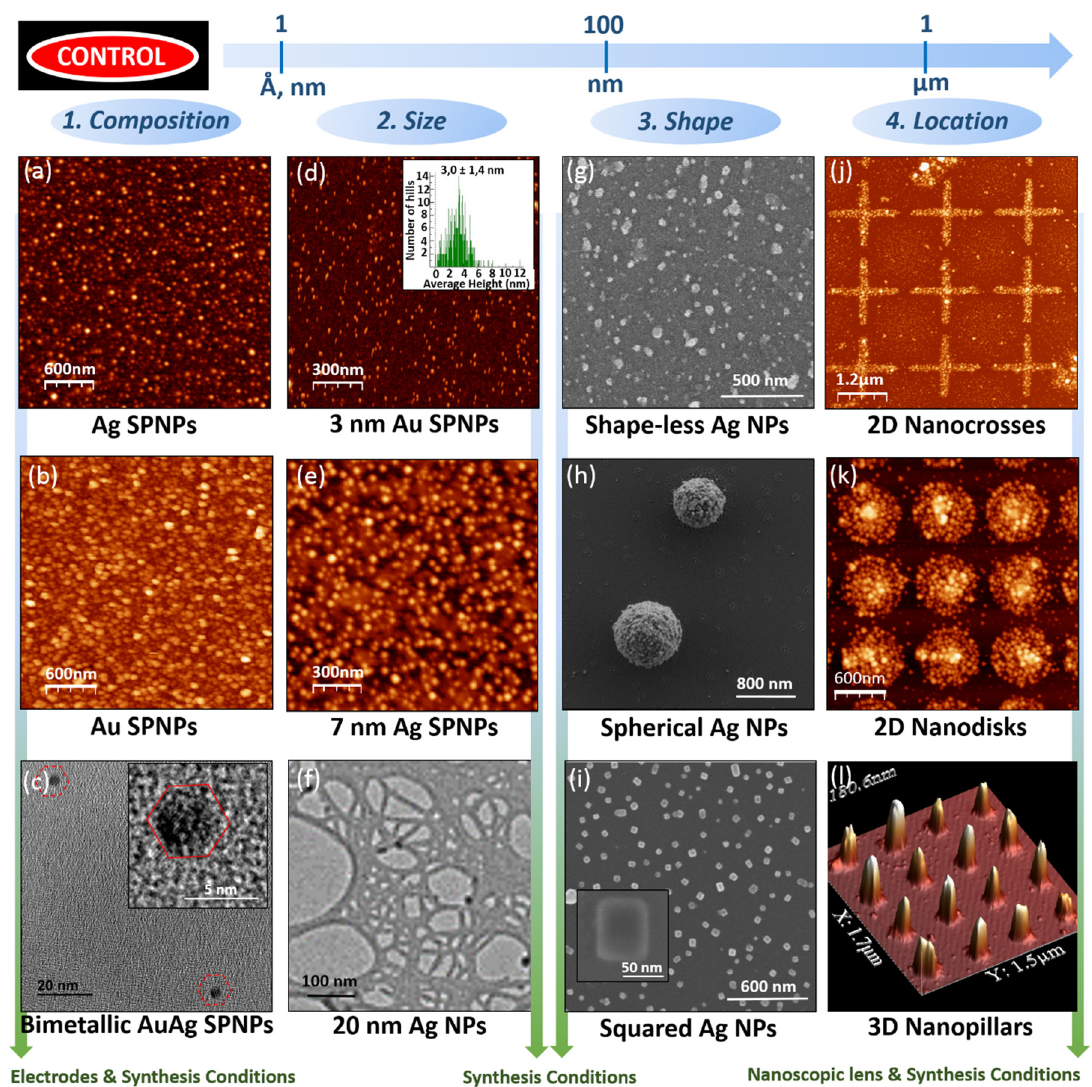
Figure 3. Tuned composition, size, shape and location of SPNPs, NPs and 3D ENSs manufactured by means of the modified SDG. The most suitable imaging technique is used in each case: AFM ( a,b,d,e,j– l ), TEM ( c , f ) and SEM ( g – i ).